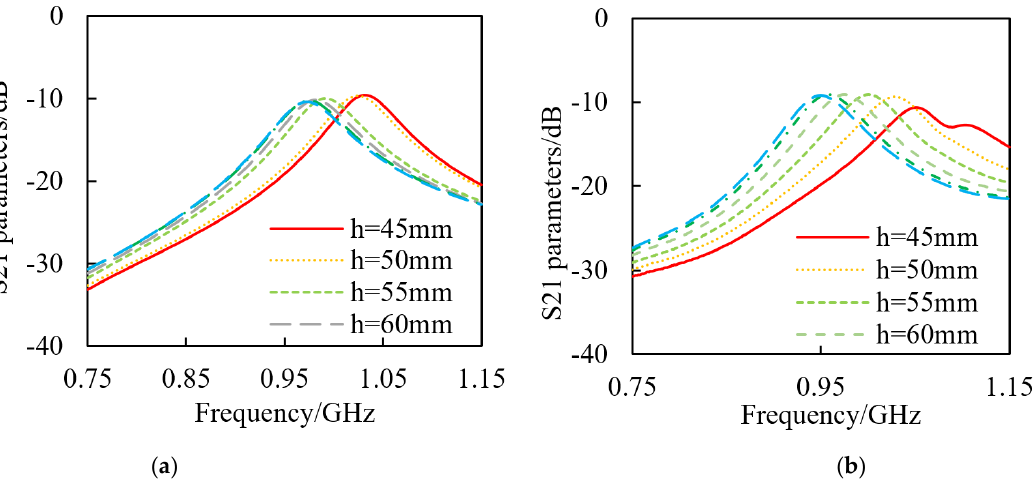
Figure 4. ( a ) The experimental platform and ( b ) the prototype.